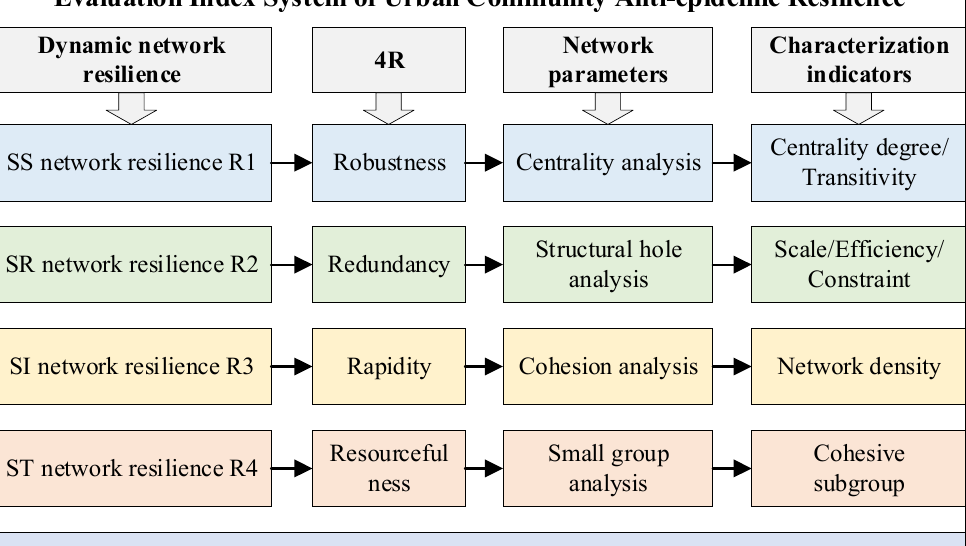
Figure 2. Flow chart of the construction of an urban community resilience evaluation index system.